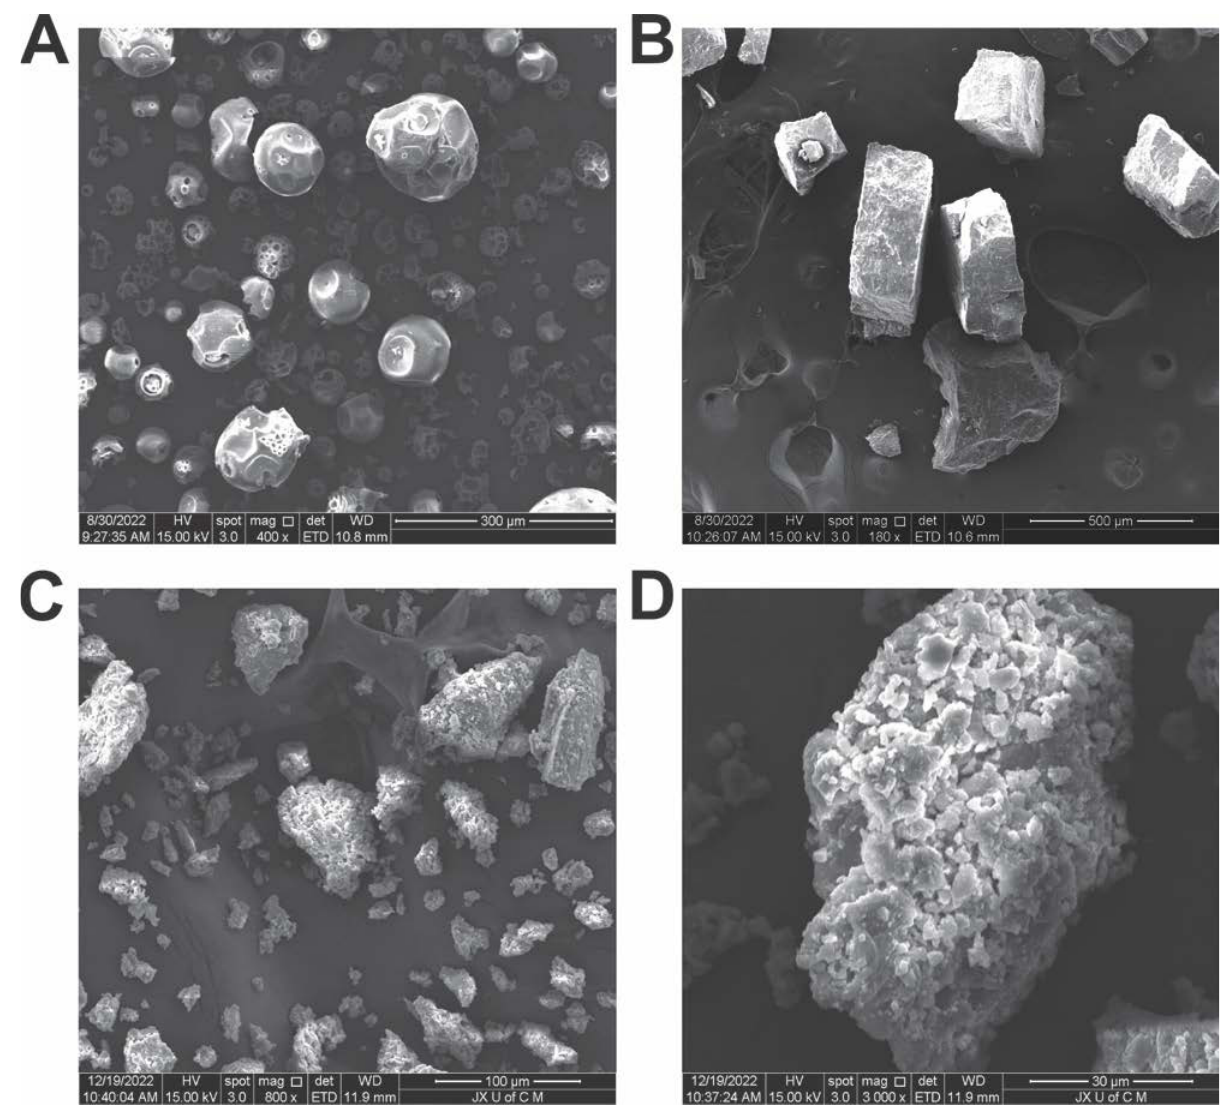
Figure 6. SEM images of HP- βCD ( A ), RIC ( B ), hydrogels at 200× ( C ), and hydrogels at 400× ( D ).